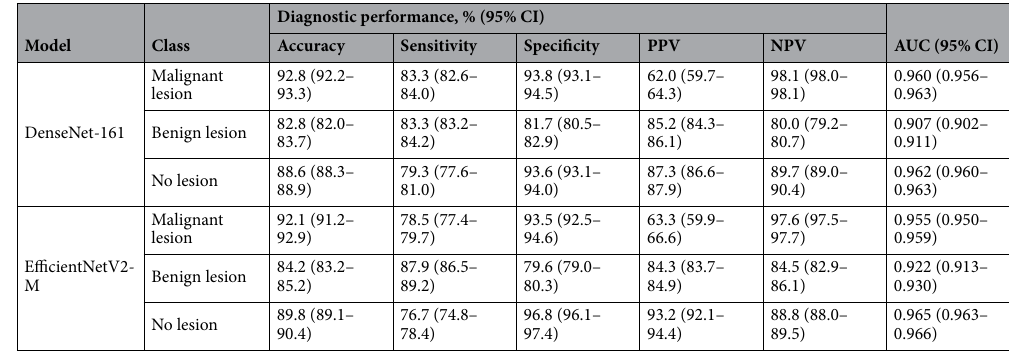
Table 2. Per-class diagnostic performances of deep-learning models differentiating malignant lesion, benign lesion, and no lesion categories. AUC area under the receiver operating characteristic curve, CI confidence interval, NPV negative predictive value, PPV positive predictive